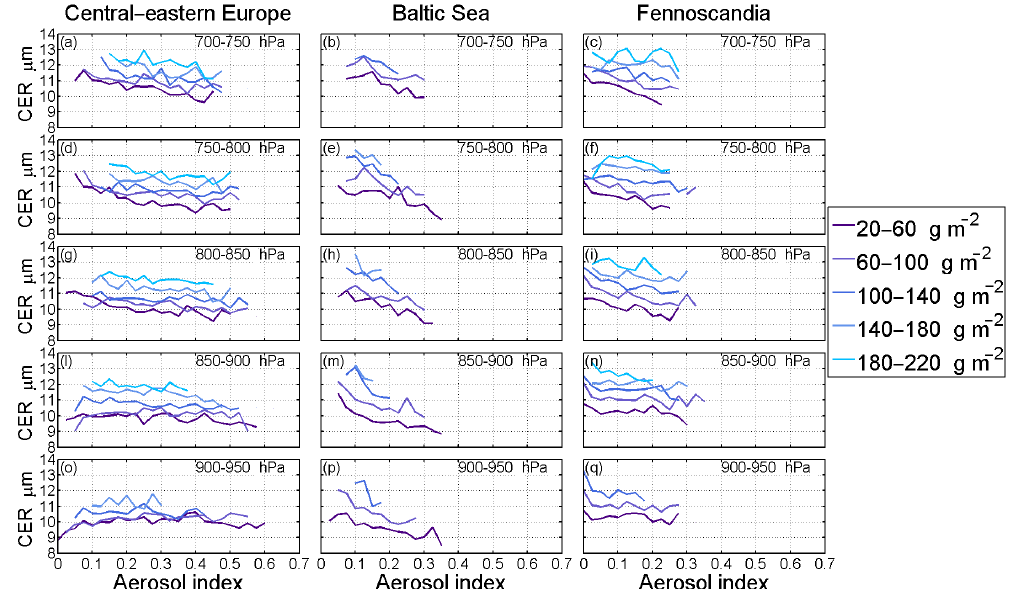
Figure 5. CER as a function of AI, stratified for subranges of CTP and LWP, for the three subregions. The legend on the right of the figure lists the LWP bins.